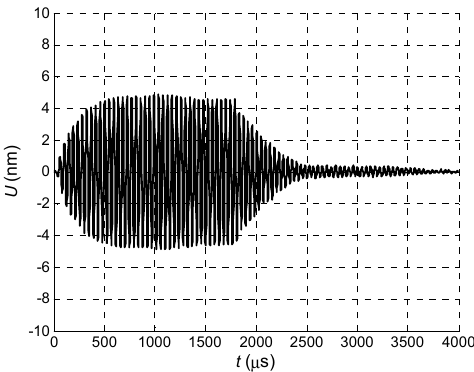
Figure 26. Normal displacement signal U of the clear PVC film, measured at L = 1 mm, when all array elements are excited simultaneously.